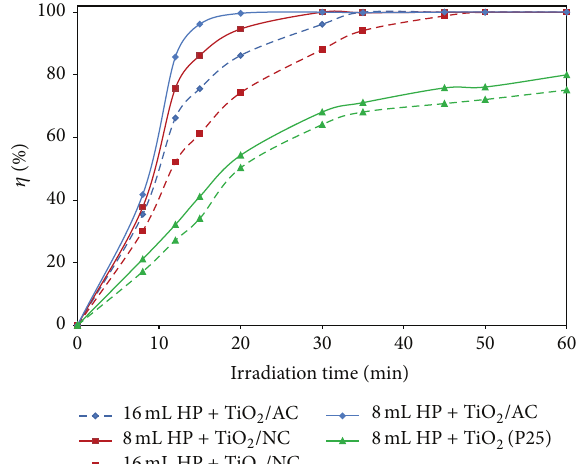
Figure 8: Effect of HP concentration on photocatalytic degradation of MG using TiO 2 (P25), TiO 2 /NC, and TiO 2 /AC (initial concen- tration of MG = 75 mg/L, photocatalyst amount = 0.75 g/L, and irradiation time = 30 min at pH = 7).